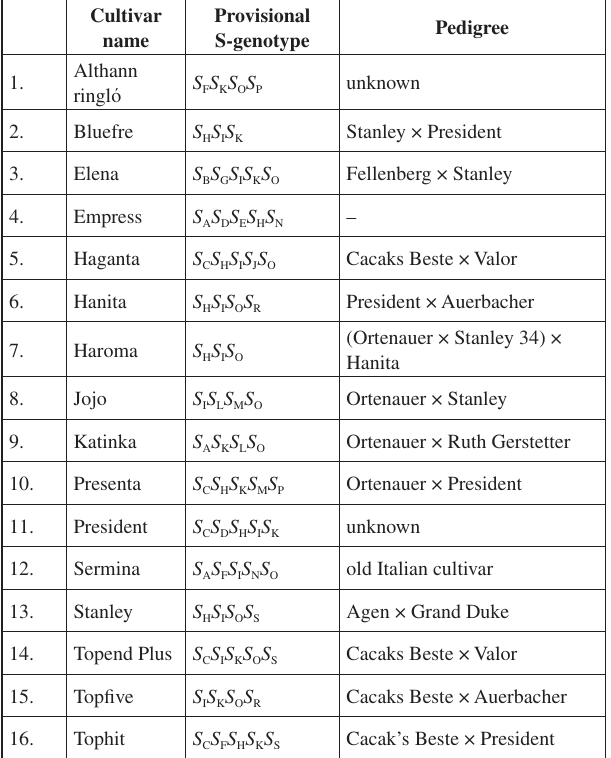
Table 1. List of European plum cultivars with the S -genotype and their pedigree ( Surányi & Erdôs ,